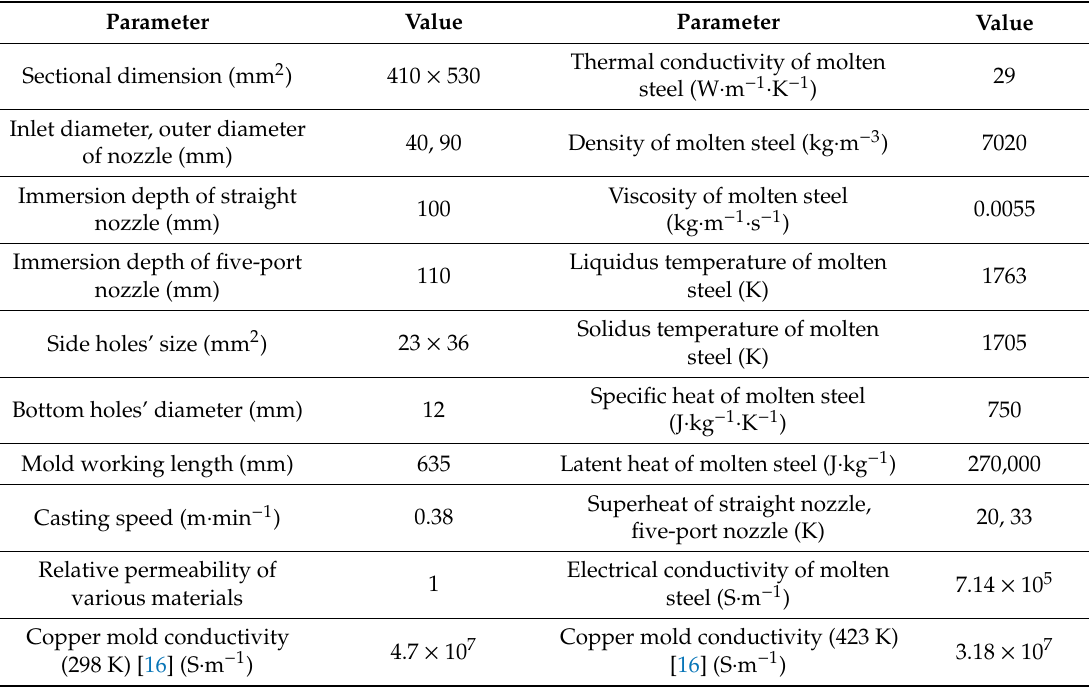
Table 2. Geometric and thermal-physical parameters used in the current